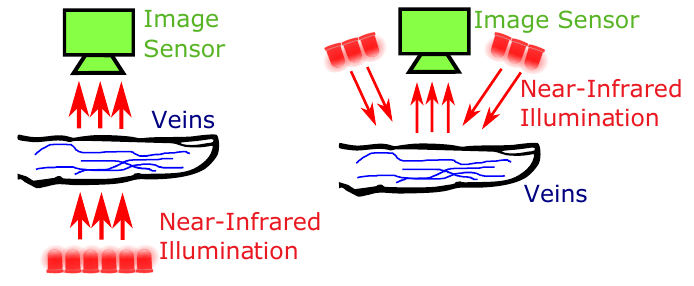
Figure 1. Light source and image sensor positioning, left: light transmission, right: reflected